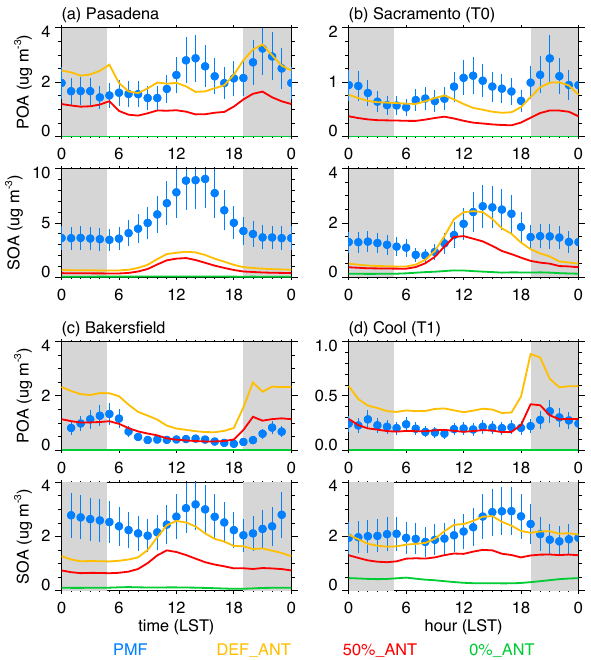
Figure 13. Diurnal averages of primary and secondary organic aerosol components at the (a) Pasadena, (b) T0, (c) Bakersfield, (d) T1 sites. Blue dots denote values derived from AMS measure- ments using positive matrix factorization (PMF) techniques. Simu- lated POA and SOA are the total of the first four model size bins up to 0.625µm diameters. Gray shading denotes night and vertical lines in right panels denote measurement uncertainty range. 50%_LBC simulation results not shown since they are nearly identical to those from the 50%_ANT